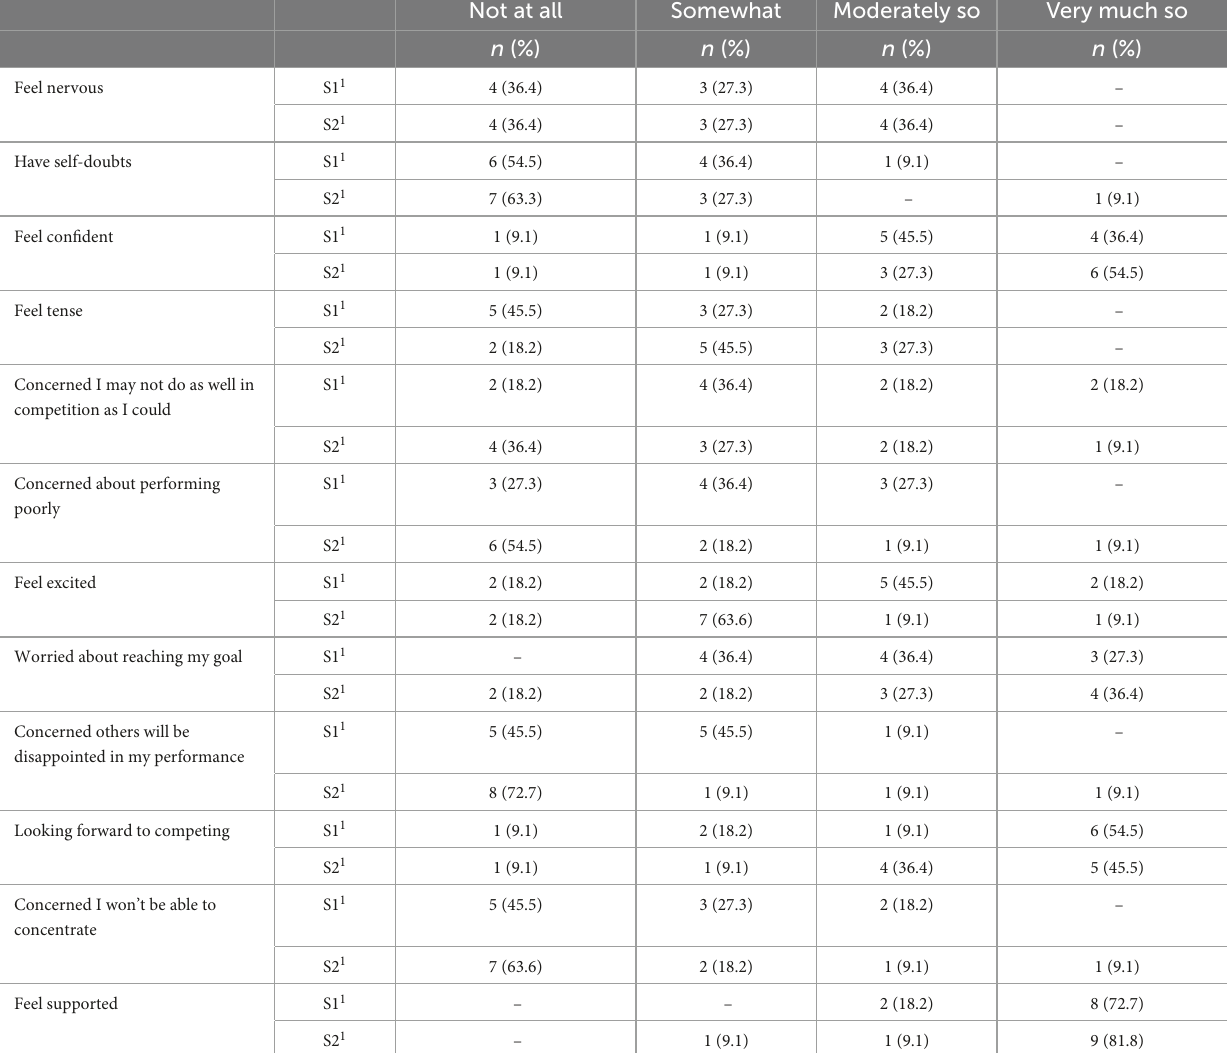
TABLE 6 Competition-related emotions in Survey 1 and Survey 2 in the 11 athletes competing in the Warrior games. Not at all Somewhat Moderately so Very much